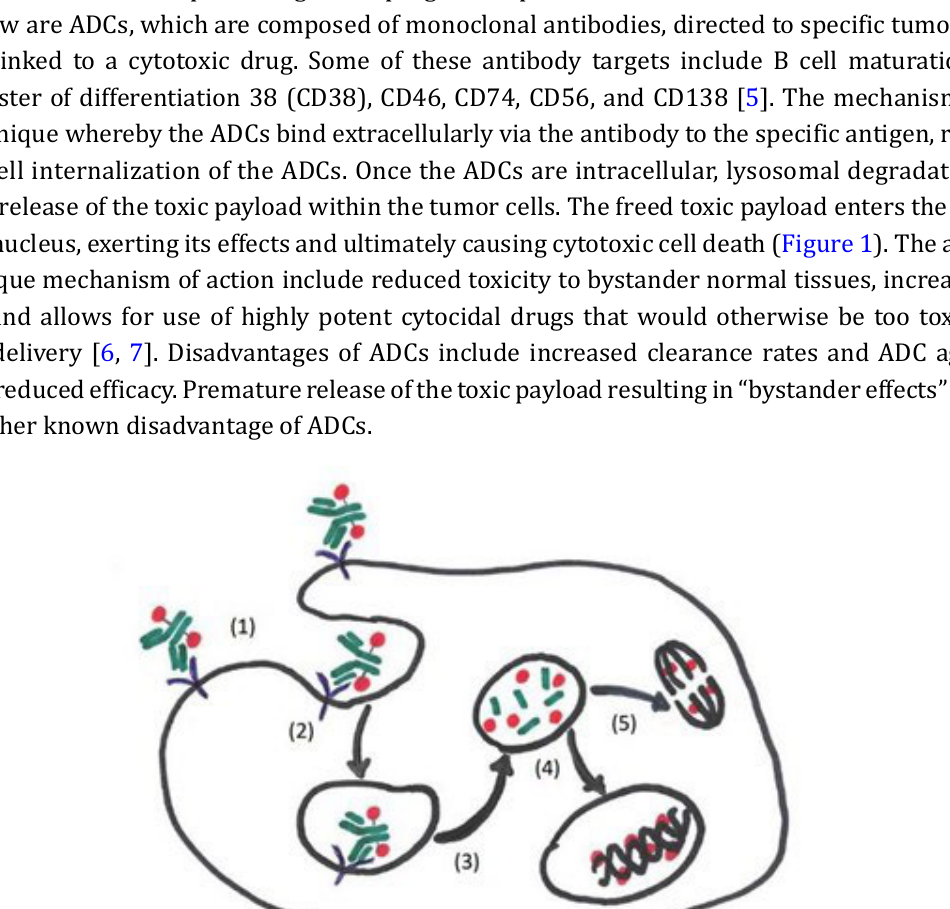
Explor Target Antitumor Ther. 2022;3:1–10 | https://doi.org/10.37349/etat.2022.00067